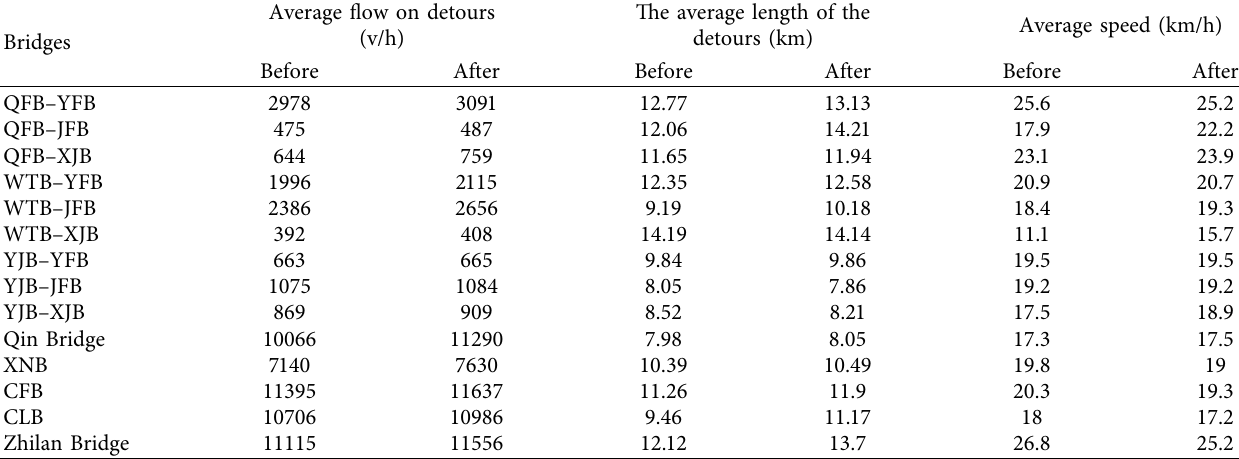
Table 3: Indicators of traffic flow on detours before and after adopting the restriction rule.